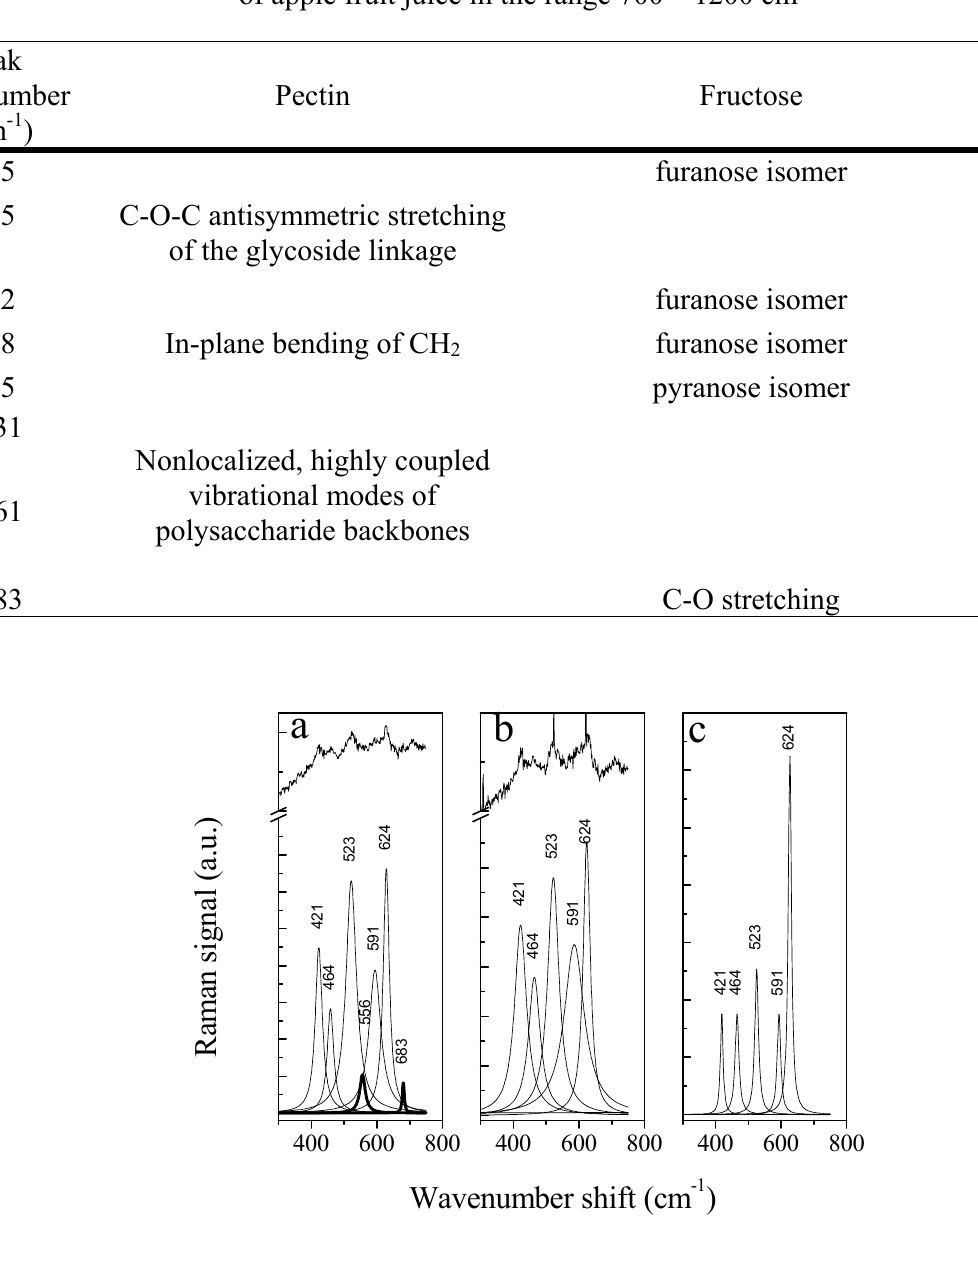
Table 2 . Tentative assignment of the main peaks in Raman spectrum of apple fruit juice in the range 700 – 1200 cm -1